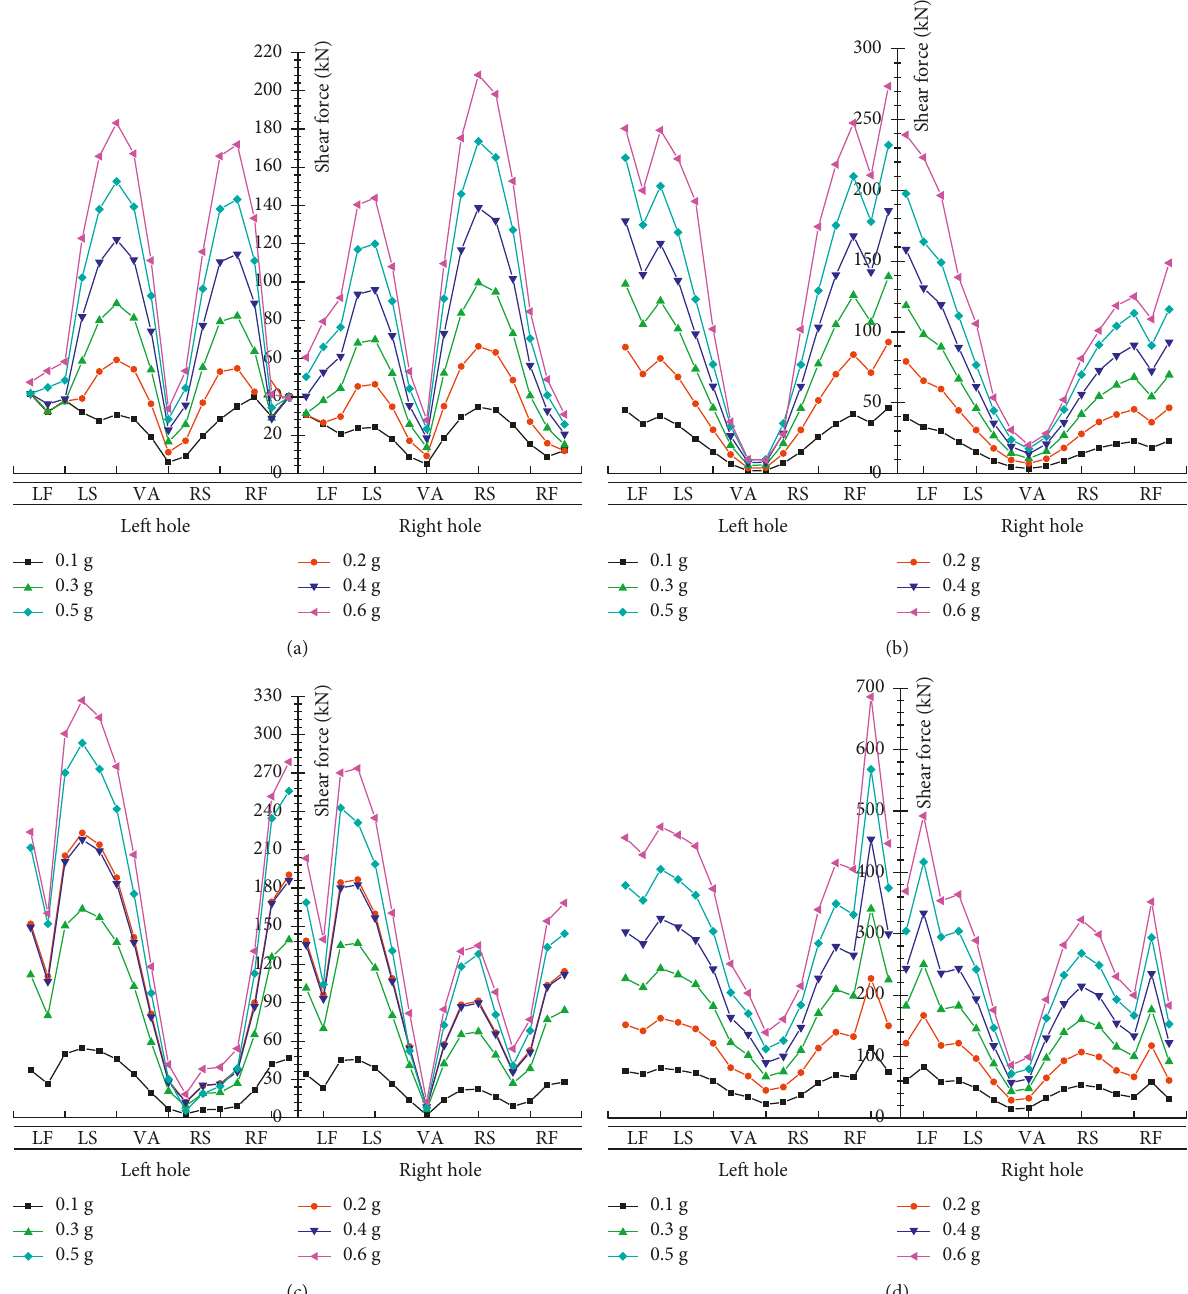
Figure 8: Shear force of the tunnel crosssection with different loading modes. (a) X direction; (b) Z direction; (c) XZ direction; (d) XYZ